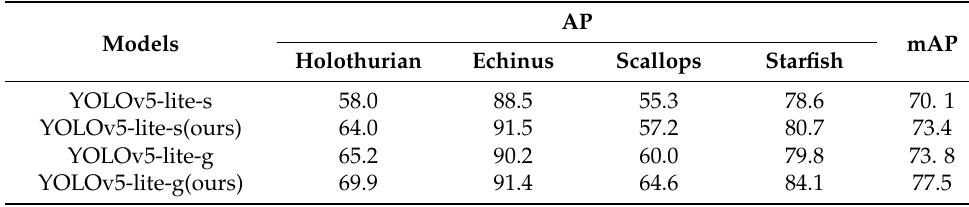
Table 4. Comparison of target type